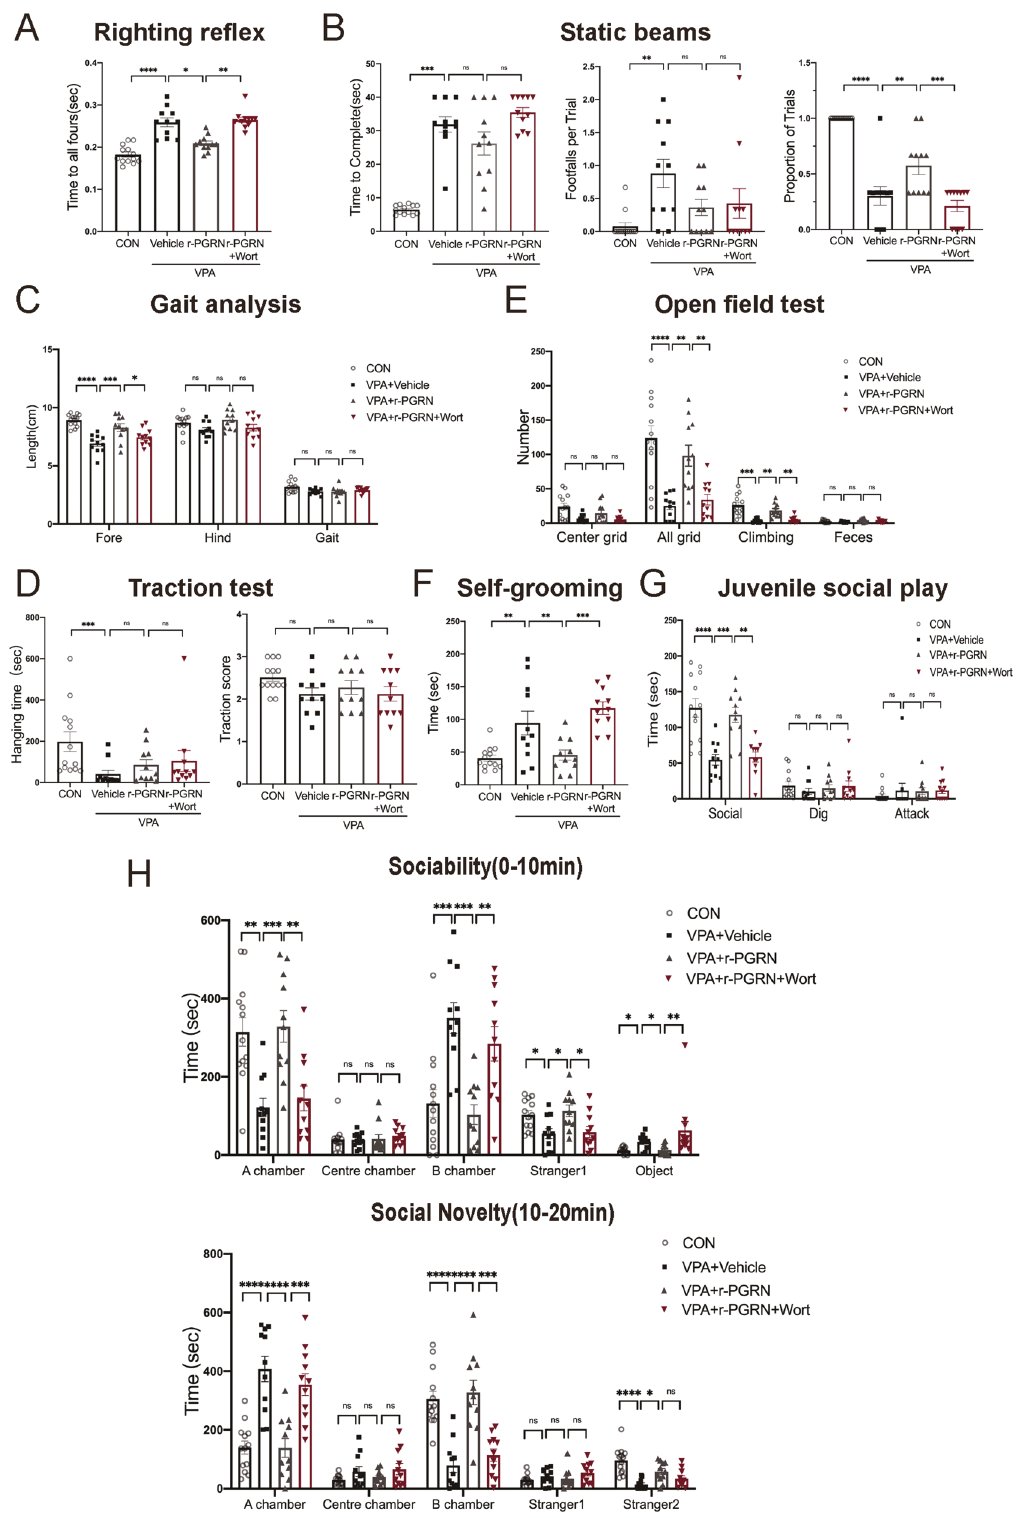
Fig. 4 r-PGRN improved the defection of behaviours, and PI3K inhibitor wortmannin blocked this effect in VPA-induced rats. Cerebellum- related behaviours: righting re fl ex ( A ), static beams ( B ), gait analysis ( C ), traction test ( D ). Autism-like behaviours: open fi eld test ( E ), self- grooming test ( F ), juvenile social play ( G ), and the three-chamber social test ( H ). Data are expressed as mean ± SEM. One-way ANOVA followed by Tukey ’ s post hoc (B (Proportion of Trials) , C (Fore, Hind, Gait) , D (Traction score) , E (All grid, Faeces) , F, G (Social) , H (10min: Stranger1, A chamber, B chamber) , H (20min: – Wallis test for multiple comparisons (A, B A chamber, B chamber) ); post hoc Kruskal (Time to Complete, Footfalls per Trial) , D (Hanging time) , E (Centre grid, Climbing) , G (Dig, Attack) , H (10min: Object, Centre chamber) , H (20min: Stranger1, Stranger2, Centre chamber) ). (ns no signi fi cant difference, * P < 0.05, ** P < 0.01, *** P < 0.001, **** P < 0.0001, sample sizes ( n ): n (CON) = 13, n (VPA + Vehicle) = 11, n (r-PGRN) = 11, n (r-PGRN + Wort) =